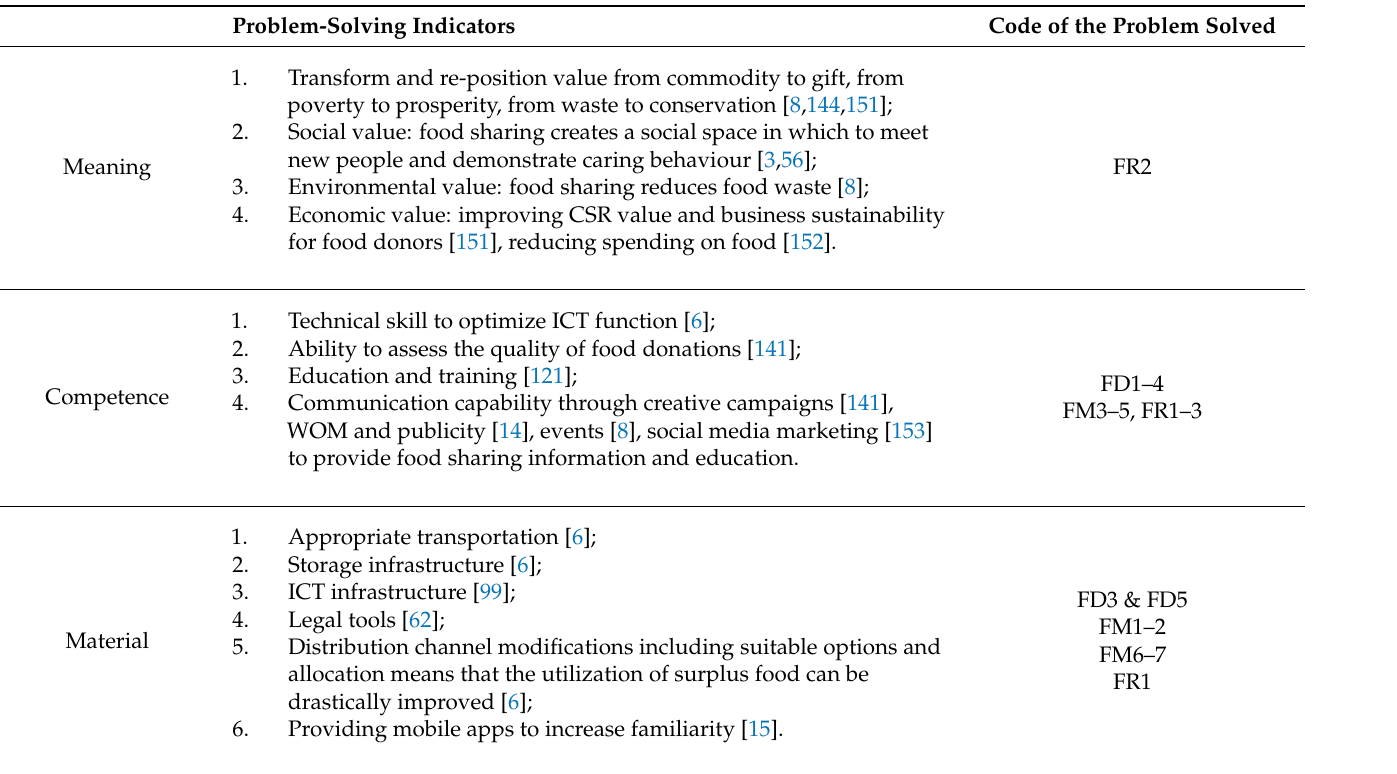
Table 4. Problems-solving analysis from a Social Practice Theory perspective.